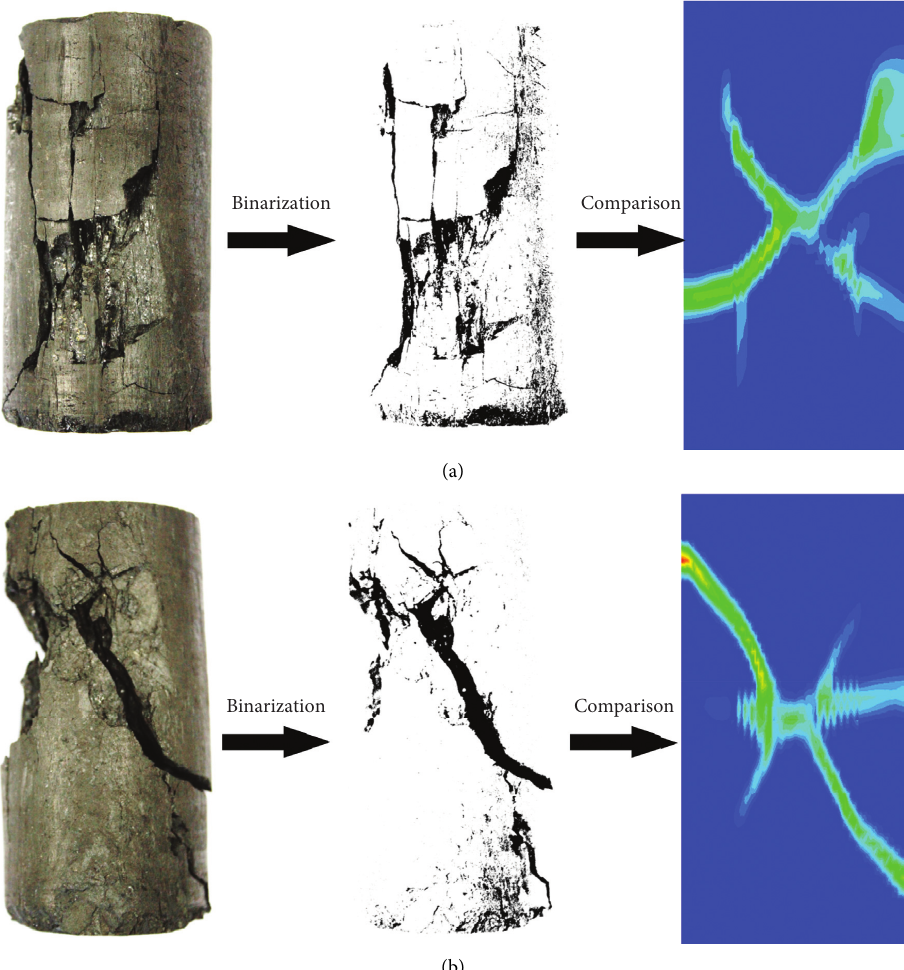
Figure 12: Comparison between the tests images and numerical results in terms of failure characteristics of coal specimens with bursting proneness: (a) high bursting proneness; (b) low bursting